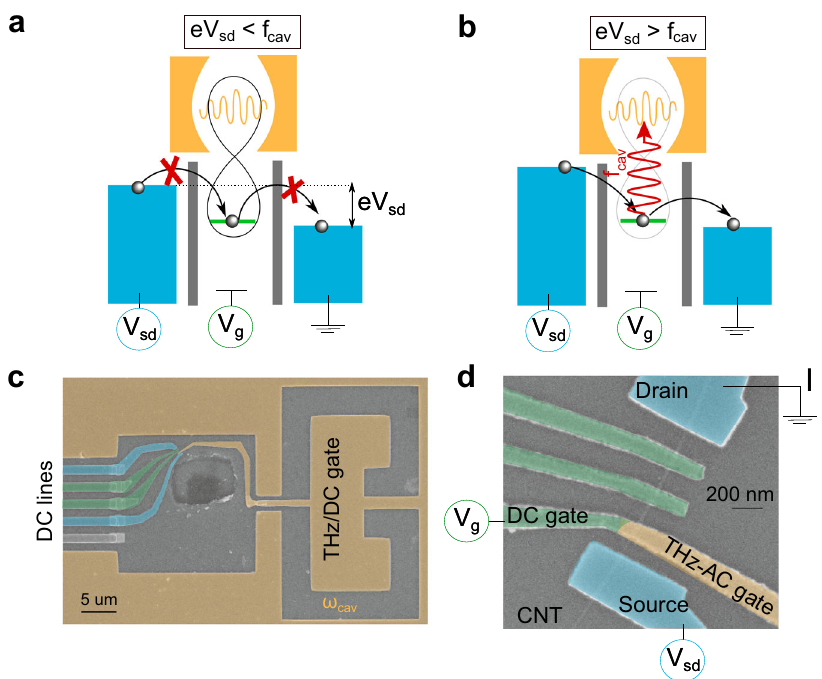
Fig. 1 Device geometry and working principle. a Cartoon picture of the process leading to the gap. At low bias with respect to the cavity frequency f cav , the light and matter hybridize ultra-strongly, leading to a blockade of the current even though the cavity is in its vacuum state. b Cartoon picture of the process leading to the gap. At high bias with respect to the cavity frequency f cav , the light and matter are not hybridized anymore and the current is de-blocked via photon emission processes ( n = 1 process sketched here). The process a. illustrates the appearance of a band gap induced by the vacuum fl uctuation of the cavity. c SEM picture of the devices: the THz cavity is capacitively coupled to the QD in the CNT. d Close-up of a similar device showing contacts and top gates on the CNT. The gate layout is slightly different than for panel c . I is the current fl owing through the